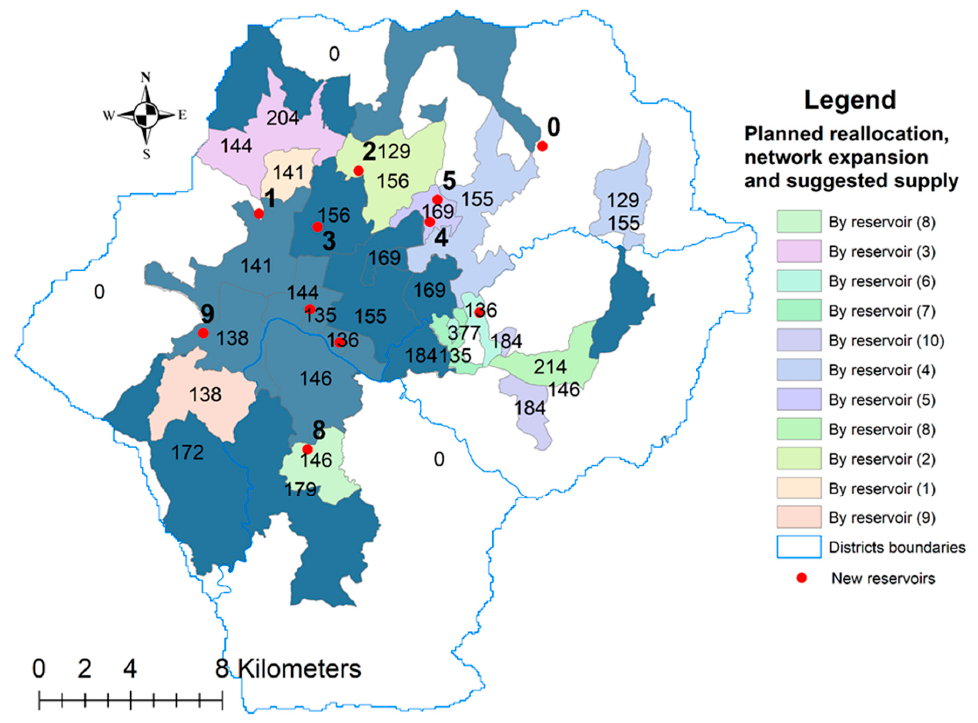
Figure 6. Water redistribution scenario by respective reservoir (values in lpcd) with improved distribution network in KV (reservoir 0 is the main reservoir at Sundarijal, which receives water from MWSP).